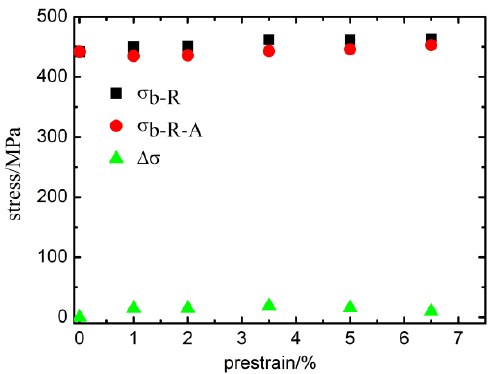
Figure 12. Decline of ultimate tensile strength after annealing: σ b-R , σ b-R-A , Δ σ represent tensile strength of prestrained specimens, prestrained specimens with annealing and the difference between prestrained and prestrained specimens with annealing.